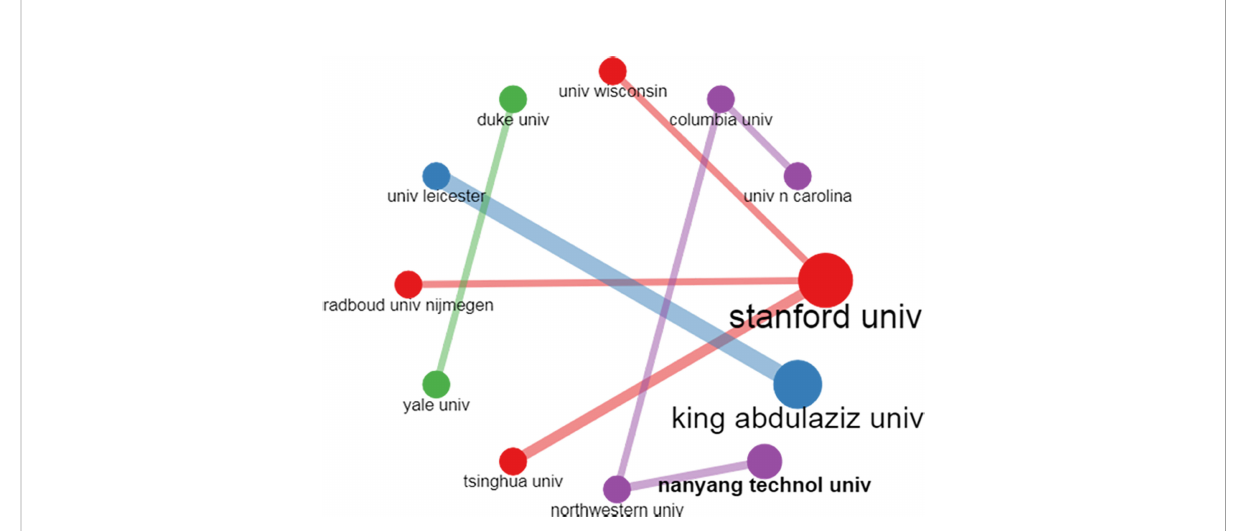
FIGURE 9 Pictorial representation of the institution ’ s collaboration using the institution collaboration network map.